Question: Summarize what this figure shows in one sentence.
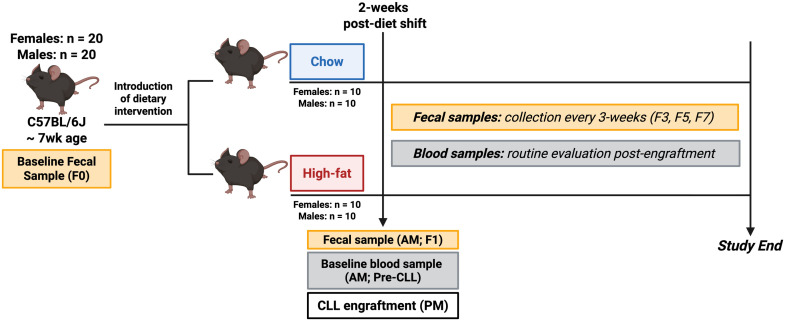
Answer: Diet modulation study outline. Study schematic illustrating the diet modulation model used. Prior to any study intervention, a baseline fecal sample (F0) was collected from all study mice (female, n = 20; male, n = 20). Subsequently, two-weeks prior CLL engraftment, wild-type (C57BL/6J) female and male mice were randomized into diet groups: female chow (F-CH; n = 10), female high-fat (F-HF; n = 10), male chow (M-CH; n = 10), and male high-fat (M-HF; n = 10). Weight of mice and food intake was monitored every ten days; water consumption was also monitored every ten days. Two-weeks post-diet shift, but prior to CLL engraftment, a fecal sample (F1) and baseline (pre-CLL) blood samples were collected from all study mice. Briefly, all diet groups (n = 40) were engrafted via tail vein injection with 0.5e 7 Eµ-TCL1 spleen-derived lymphocytes from a moribund Eµ-TCL1 mouse (≥ 90% CD45+/CD19+/CD5+ peripheral blood and spleen lymphocytes). Subsequent fecal samples were collected every three weeks (F3, F5, F7). Leukemic disease burden was routinely evaluated via flow cytometry. Due to overall survival of female and male mice, female flow analyses are documented at pre-CLL, 2-weeks post-engraftment, and 4-weeks post-engraftment. Male flow analyses are documented at pre-CLL, 2-weeks post-engraftment, 4-weeks post-engraftment, 8-weeks post-engraftment, and 12-weeks post-engraftment. Mice were followed until they became moribund, as outlined in the methods, and were subsequently sacrificed.